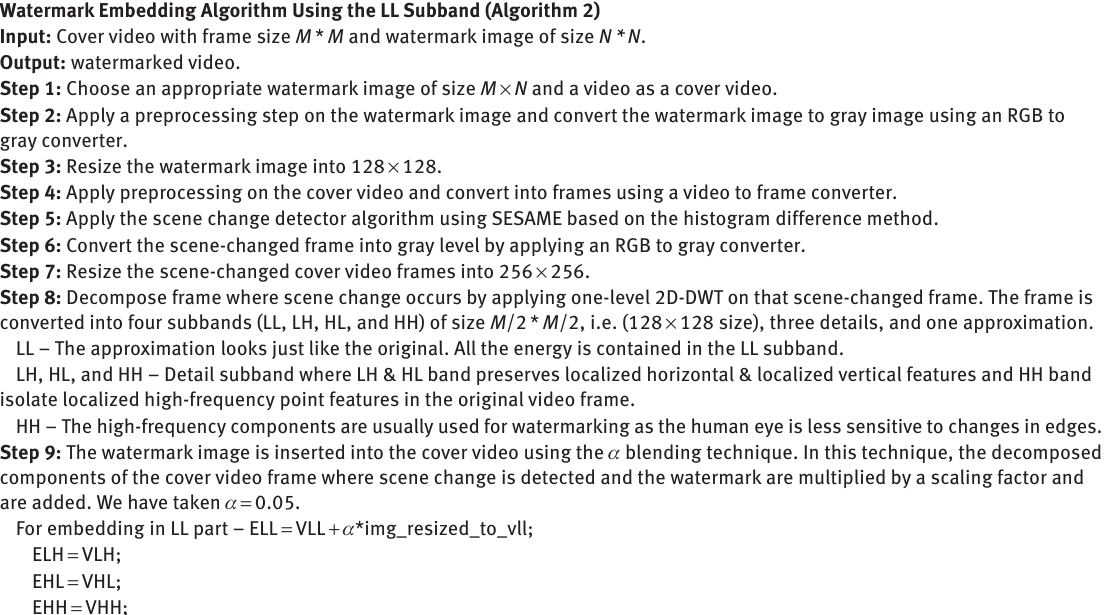
Watermark Embedding Algorithm Using the LL Subband (Algorithm 2)